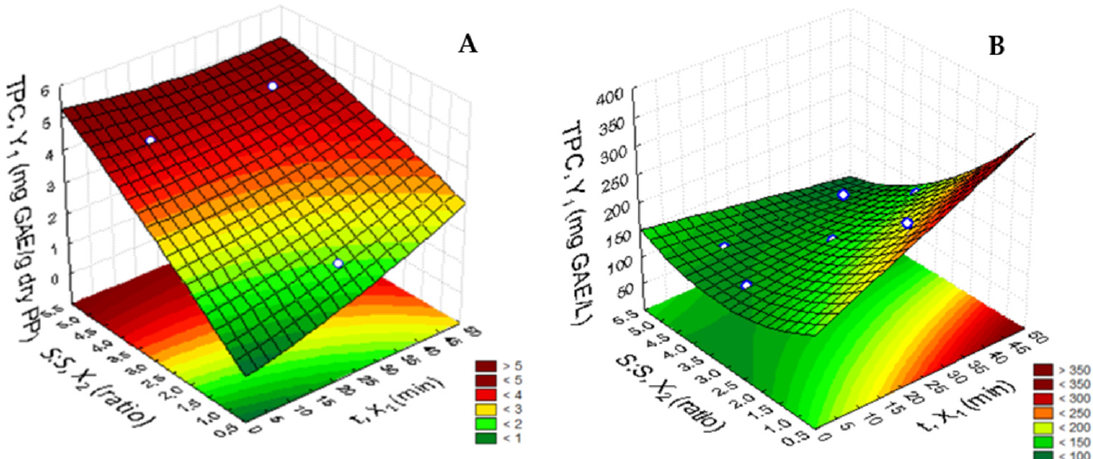
Figure 1. Response surfaces for the effect of time and water:raw material ratio on the total phenolic content (TPC) of extracts expressed as mg GAE/g dry pineapple peel ( A ) and mg GAE/L ( B ). Abbreviations: PP—pineapple peel; S:S—solvent:pineapple peel ratio; t—time.